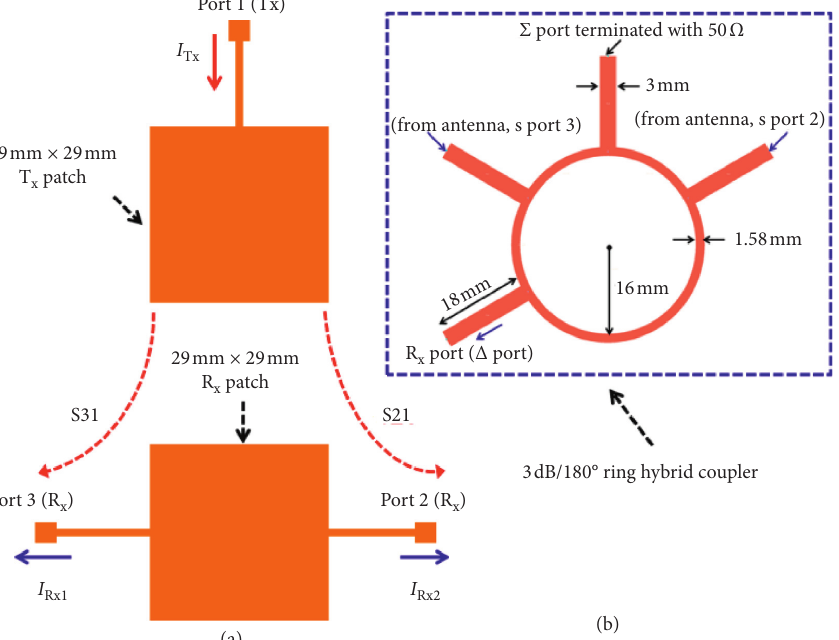
Figure 2: (a) The topology of dual polarized bistatic patch antenna system based on a single port transmit patch and two ports receive patch for differential receive mode operation to suppress the self-interference. (b) 3dB/180 ° ring hybrid coupler as a SIC